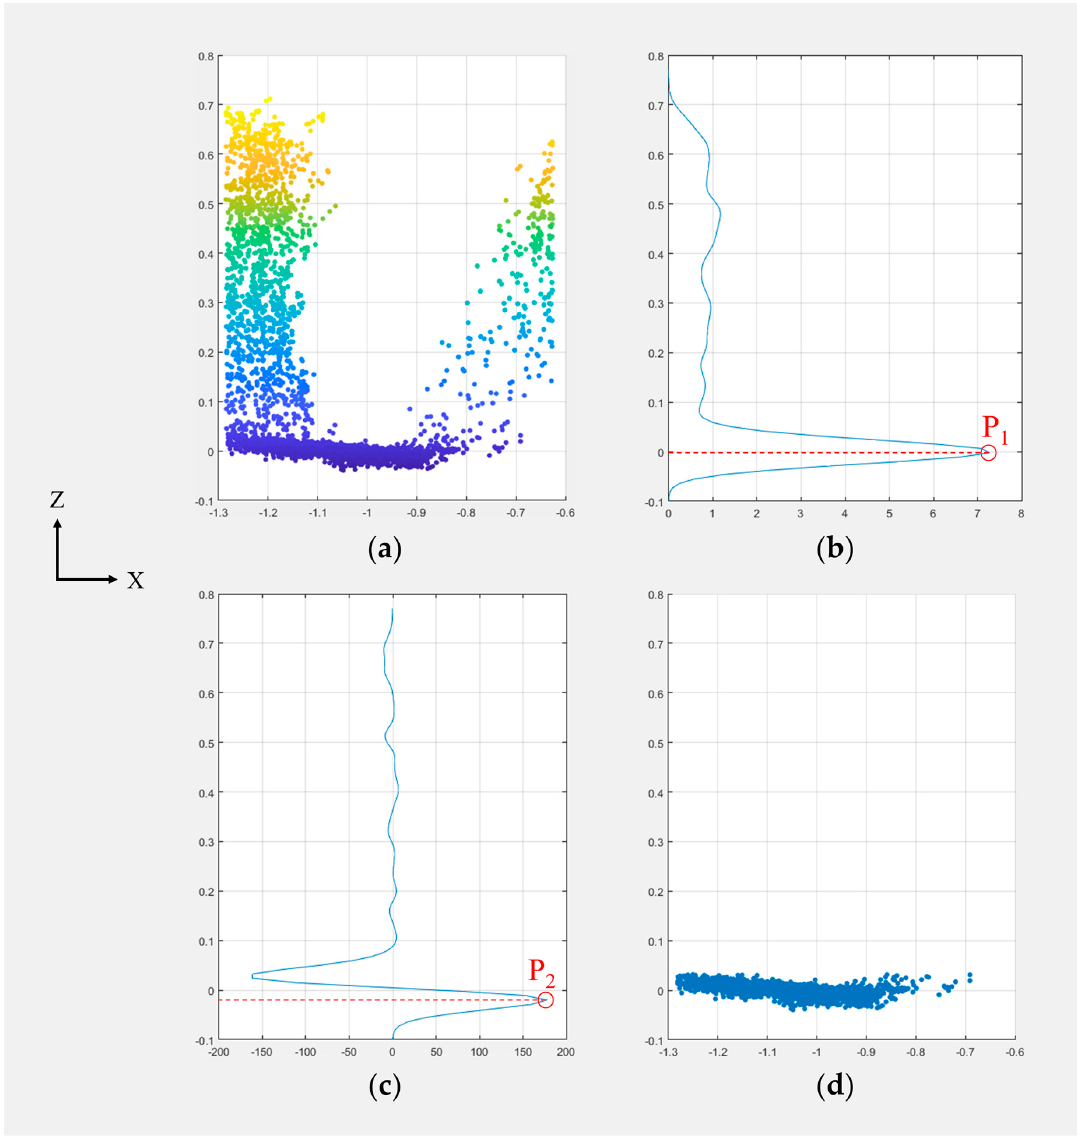
Figure A3. An example of extracting a refined alleyway point cloud: ( a ) point cloud of ground before cleaning; ( b ) point cloud kernel density in the Z dimension; ( c ) first derivative of the kernel density; ( d ) point cloud of ground after cleaning.